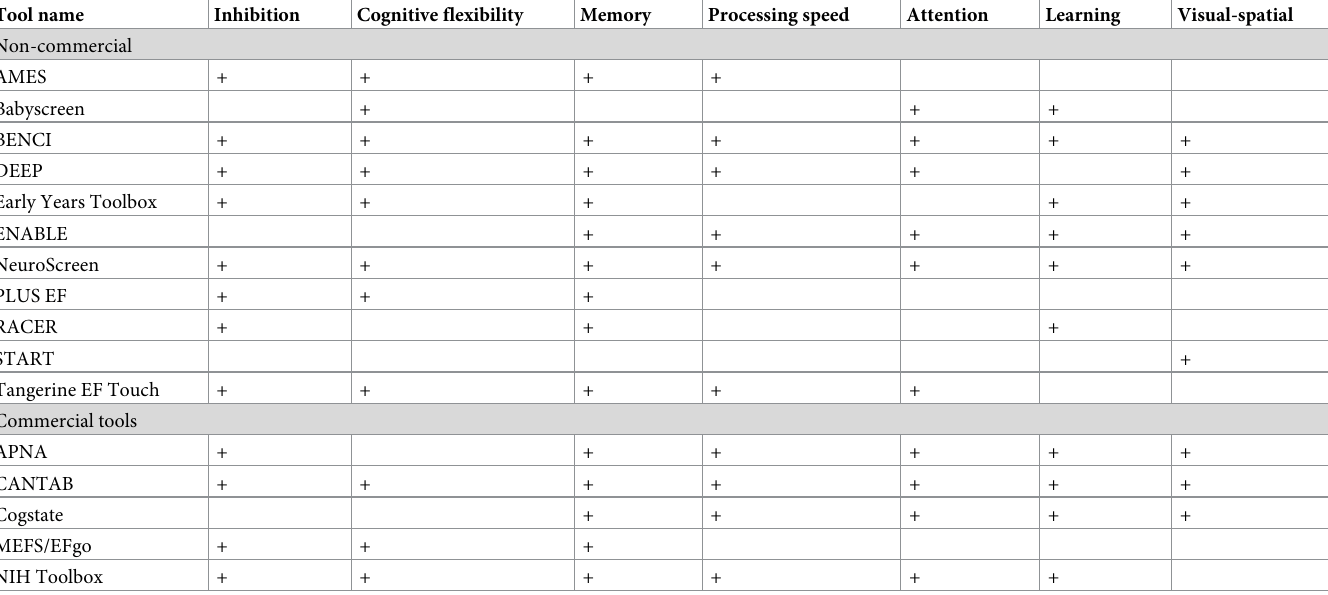
Table 2. Domains measured by tablet-based cognitive assessments. Tool